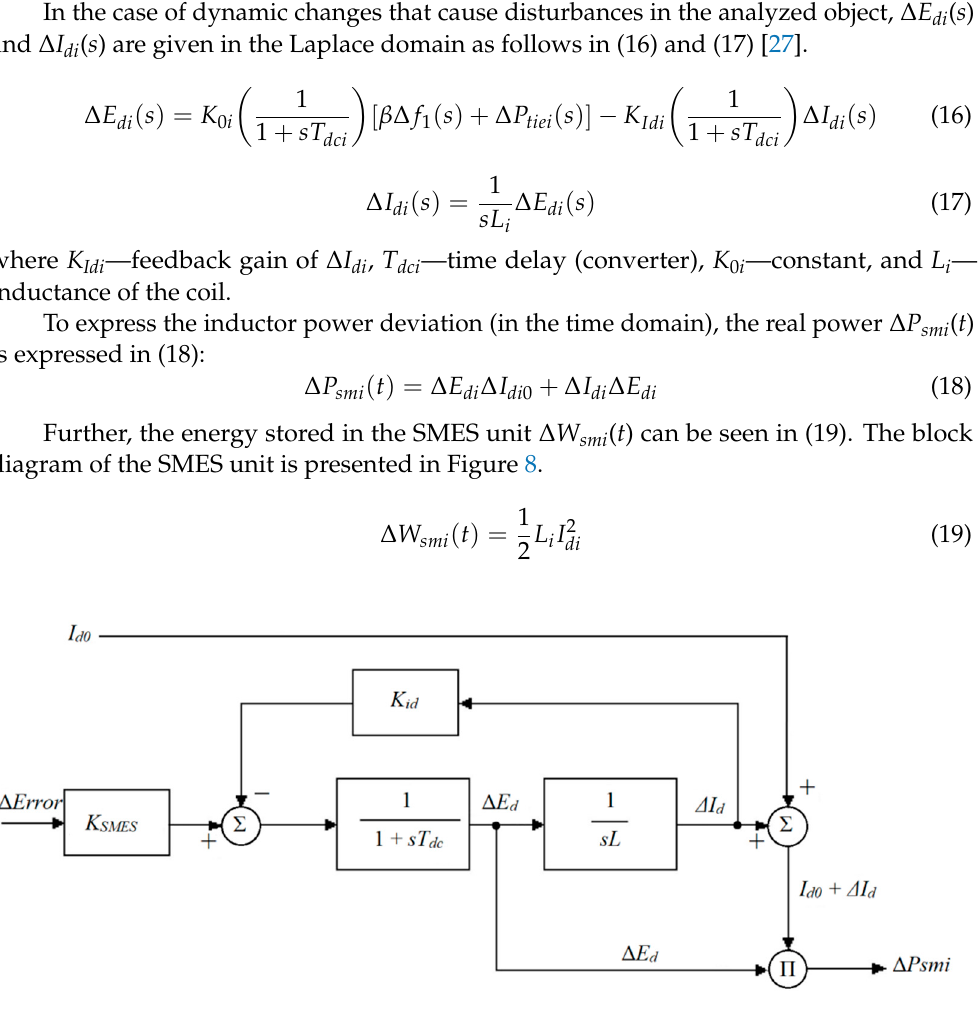
Figure 8. Block diagram of the SMES control with inductor current deviation feedback.